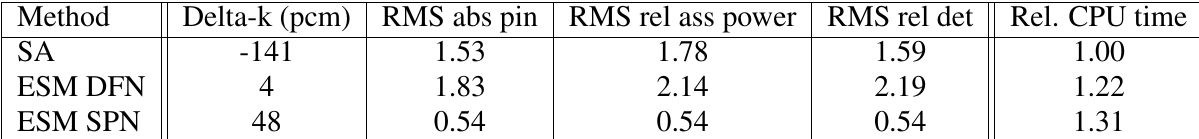
Table III: k eff , absolute pin power, relative assembly power and relative detector response percentage differences versus a Serpent 3D reference for Watts Bar 1 BOC1 HZP, and relative CPU times, for the three PANTHER models described in the